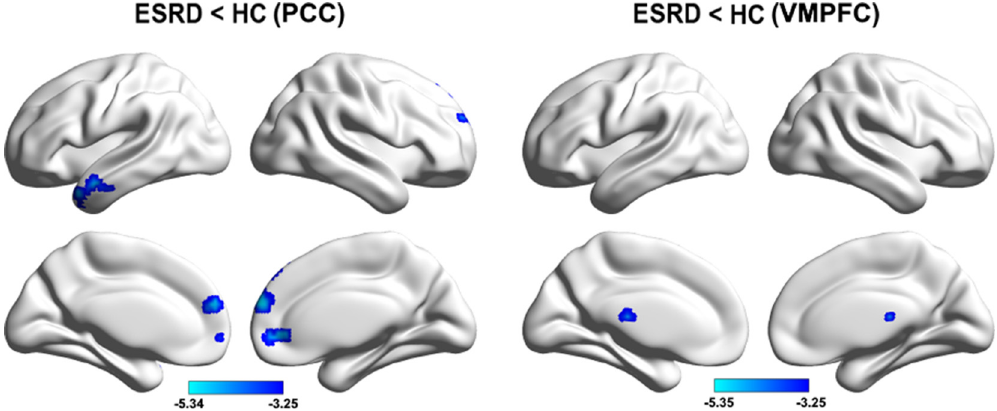
Fig 3. Between-group functional connectivity differences after excluding two patients with